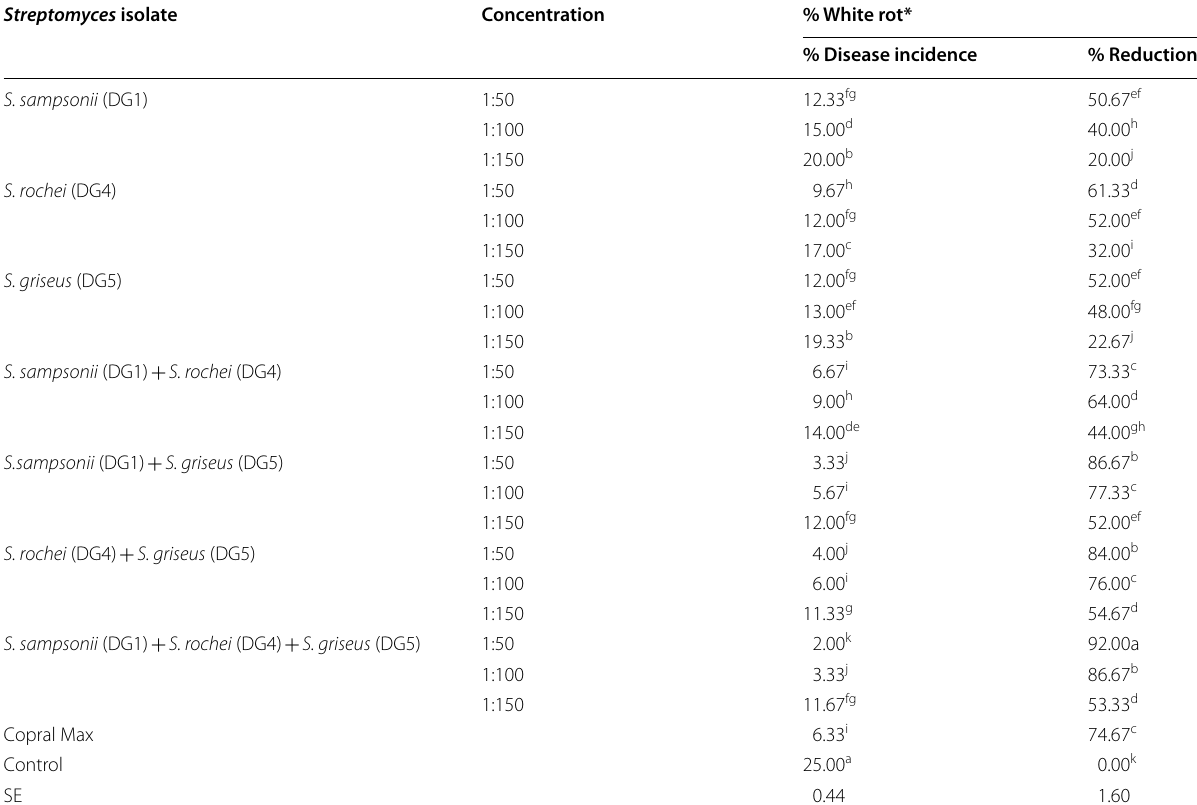
Table 2 Impact of applying Streptomyces spp. at different concentrations on bean white rot disease